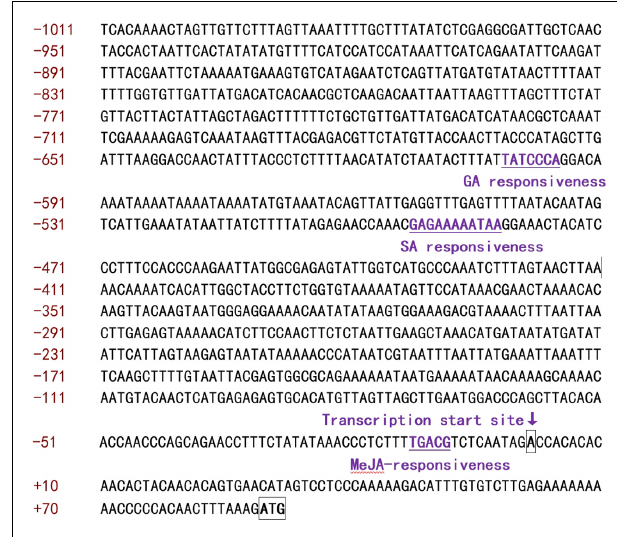
FIGURE 2 | Sequences of the 5 (cid:48) upstream flanking region of CbRCI35 . Numbering is relative to the transcription start site which was designated + 1 and indicated with an arrow. gibberellin (GA), salicylic acid (SA), and methyl jasmonate (MeJA) responsiveness associated elements were labeled and